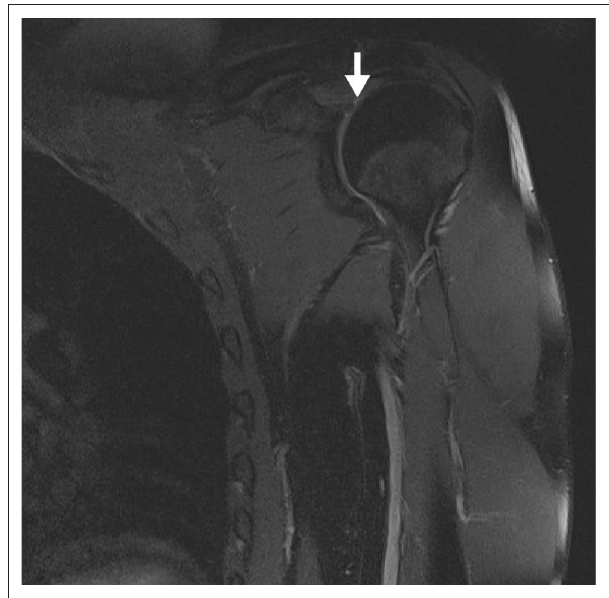
FIGURE 3: Magnetic resonance image (MRI) PD TSE FS in the coronal plane, demonstrating complete rupture of the biceps anchor (arrow).